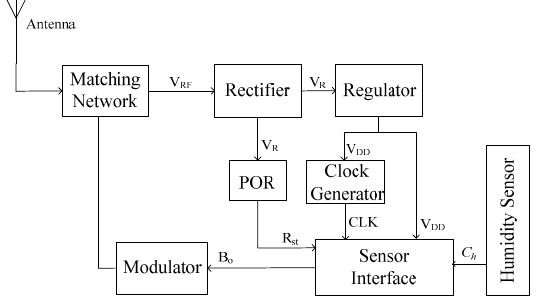
Figure 3. Architecture of the proposed wireless humidity sensor.